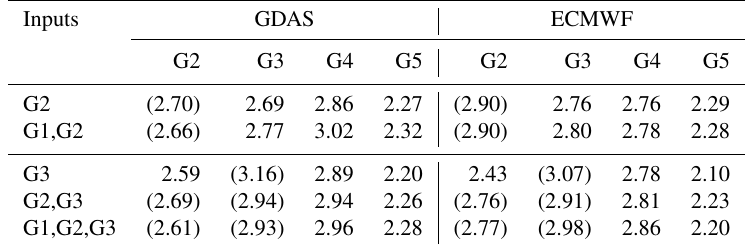
Table 5. Ranks against G2–G5 for HYSPLIT simulations after assimilating various combinations of observation inputs. The model counter- parts of the satellite mass loadings are calculated using the M1 option, i.e., integrating over three layers centered at the cloud top layer. Only the ash cells are assimilated for all the inverse cases listed here. “()” indicates that the observations have been